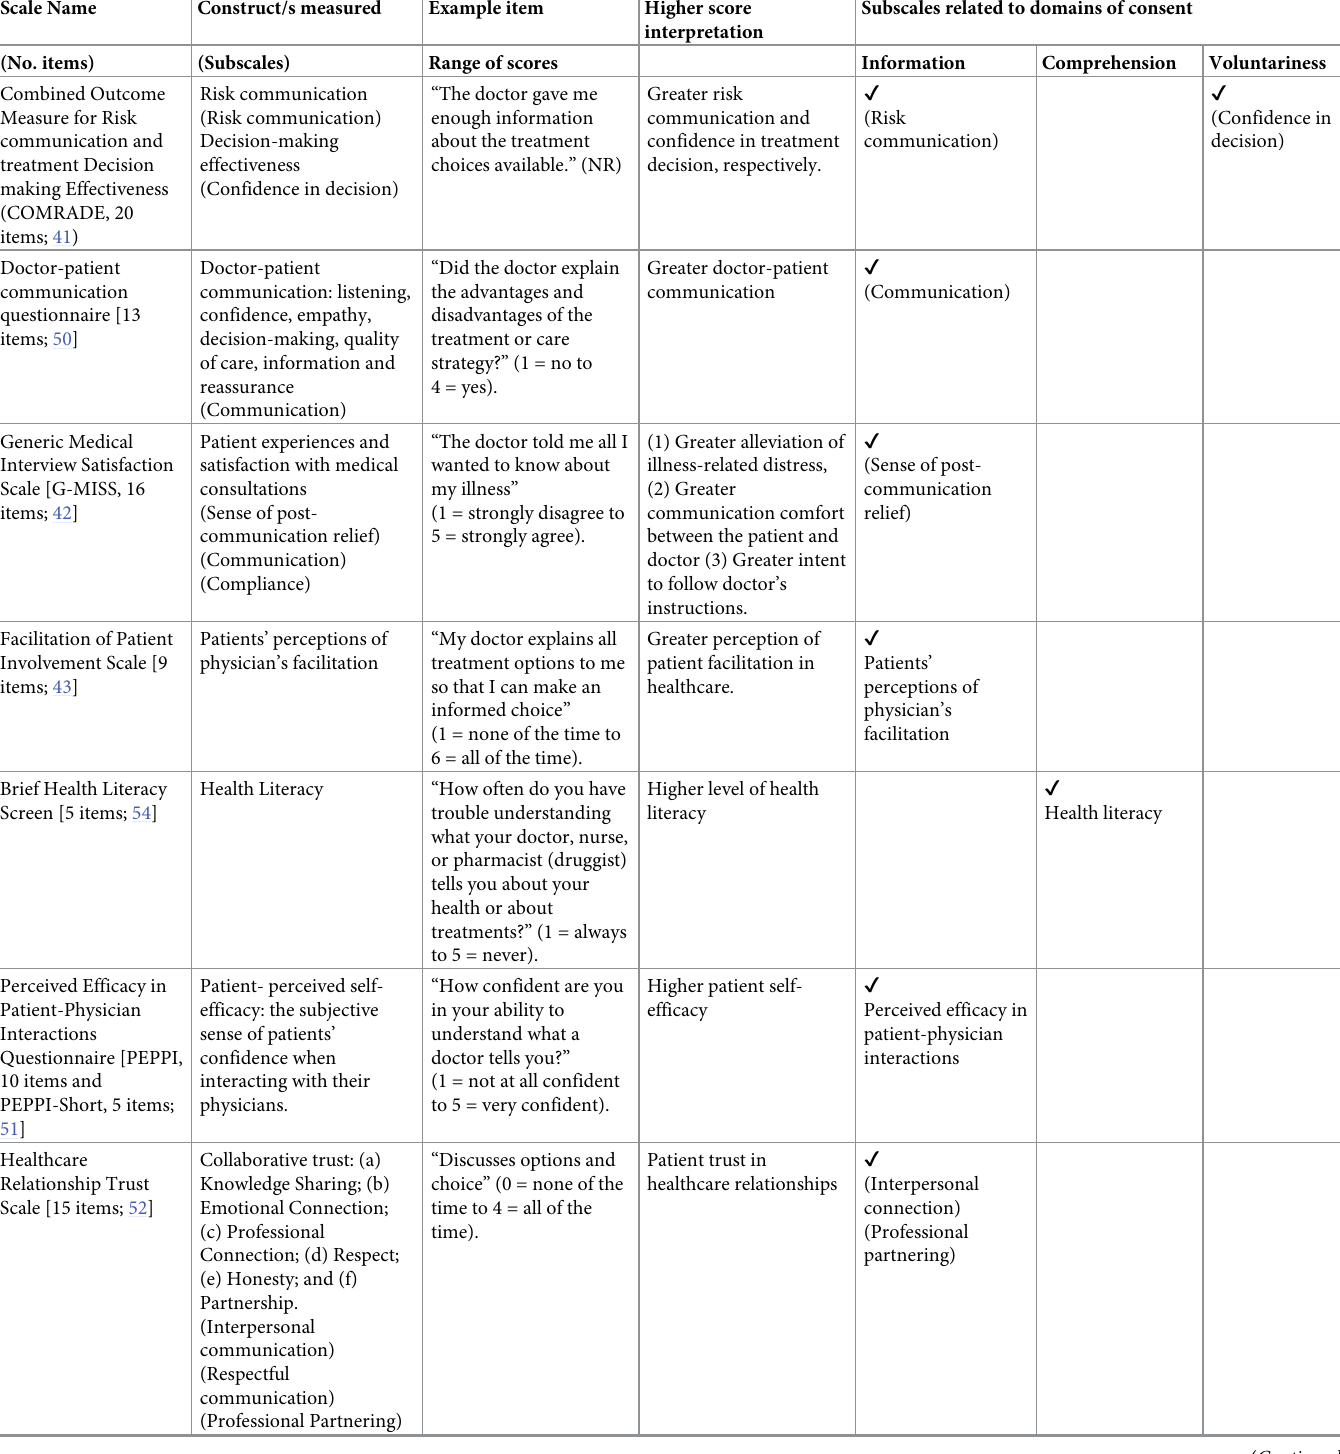
Table 3. Summary of scale papers included for